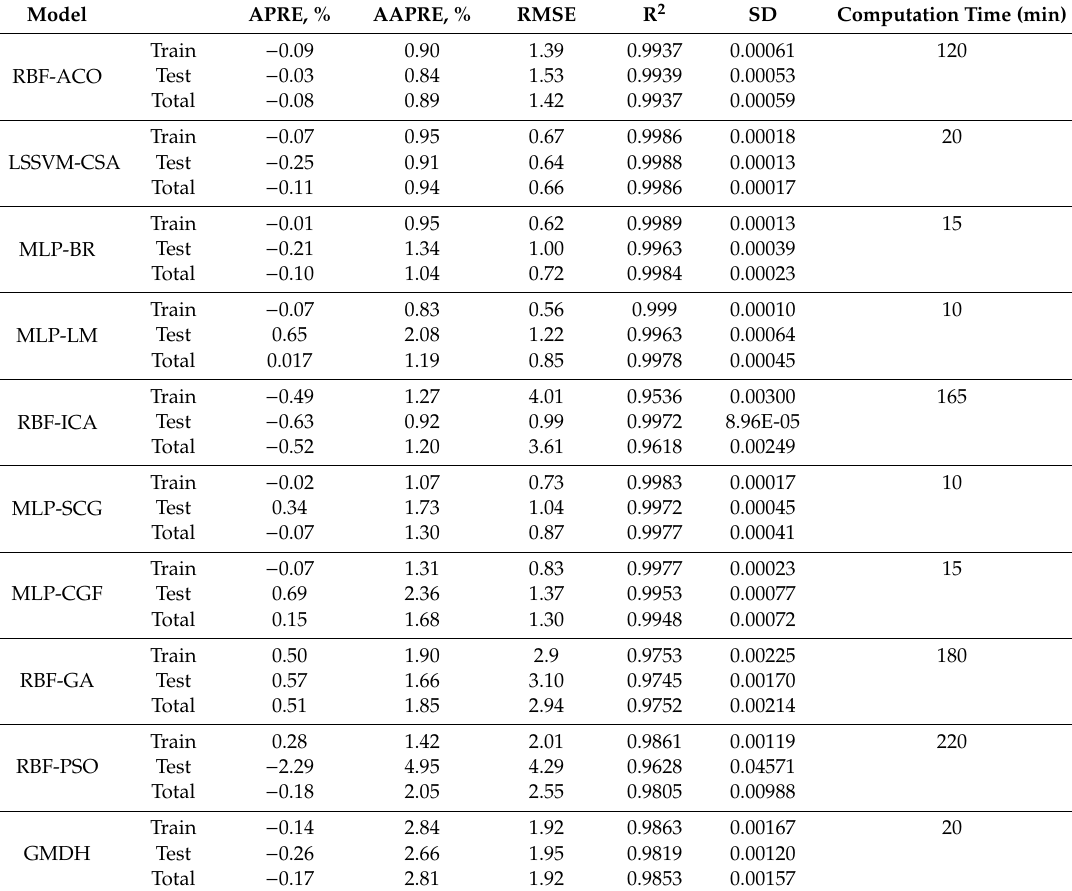
Table 4. Magnitudes of root mean square error (RMSE), standard deviation (SD), average percent relative error (APRE), average absolute percent relative error (AAPRE), computational time, and coe ffi cient of determination (R 2 ) for all the proposed models for prediction of asphaltenes adsorption. Model